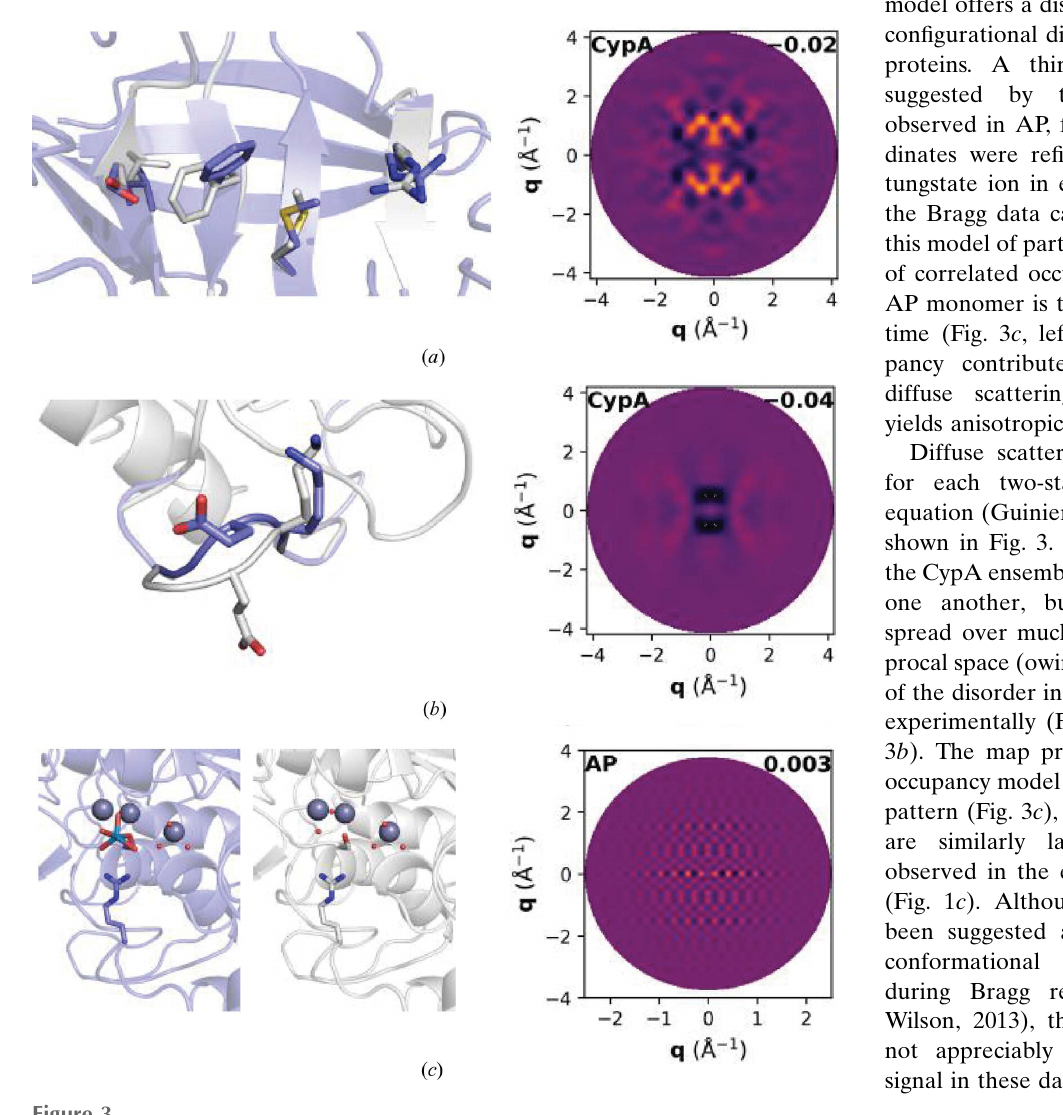
Figure 3 Ensemble models inferred from the Bragg data. ( a ) Multi-conformer modeling of the CypA electron-density map predicts a minor population of alternate conformers (purple) that radiate from the active site. ( b ) CypA data sets collected at 180 K and below show two loop conformations between residues 79 and 83; the visualized loop conformations are those modeled in the 100 K data set. Above 180 K, the conformation shown in white is not populated. ( c ) Model of AP assuming that one active site is tungstate-bound (left) while the other is occupied by water molecules that coordinate the active-site metal ions (right). The 0 kl plane of the predicted map from each ensemble model is shown on the right, with a different color scale from Fig. 1 to enhance visual contrast. The overall CC between the experimental map and each predicted map is noted in